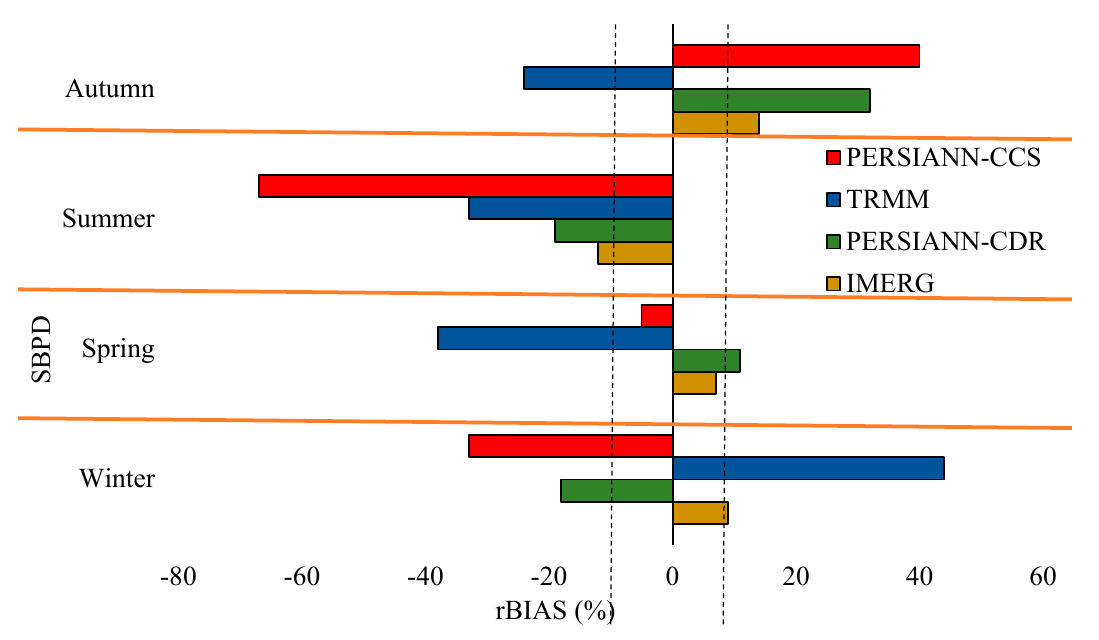
Figure 17. rBIAS (%) of all SBPD on seasonal scale.